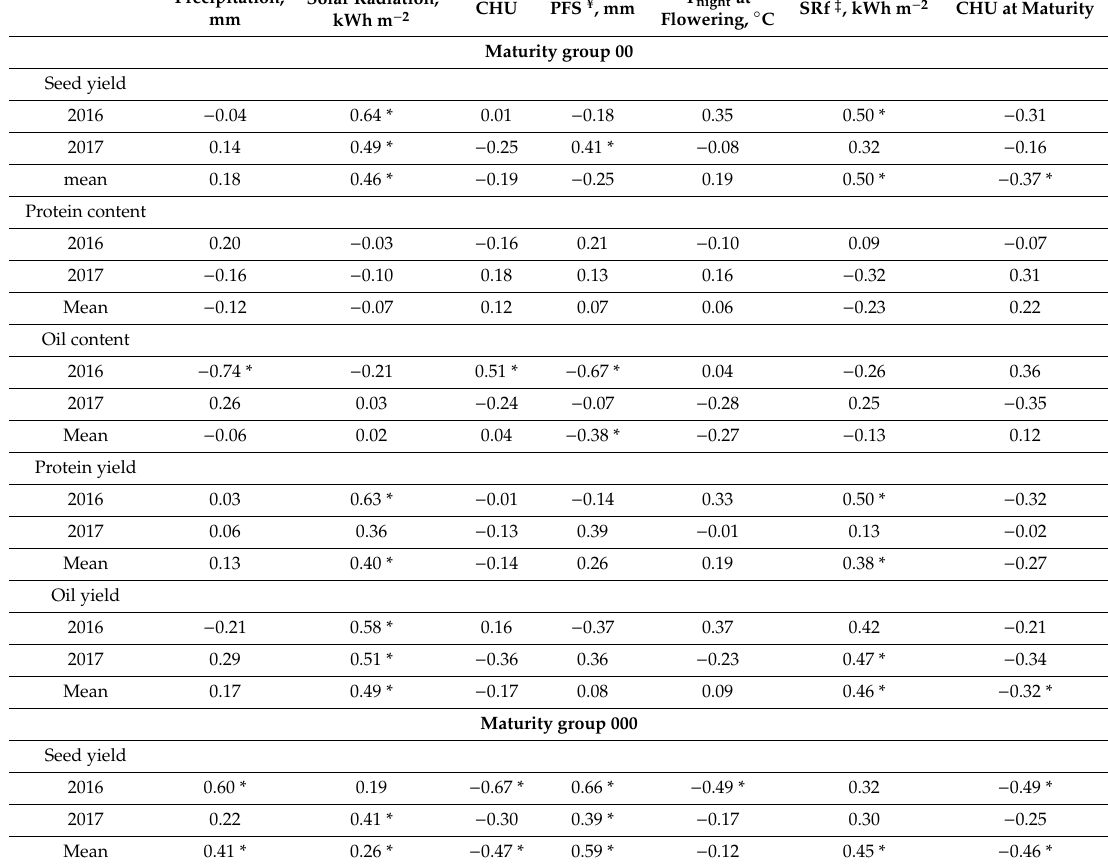
Table 6. Correlations between environmental conditions and seed traits of soybean ( Glycine max ) across five locations and 13 varieties in Germany in the years 2016 and 2017 respectively, and averaged over both years, p <